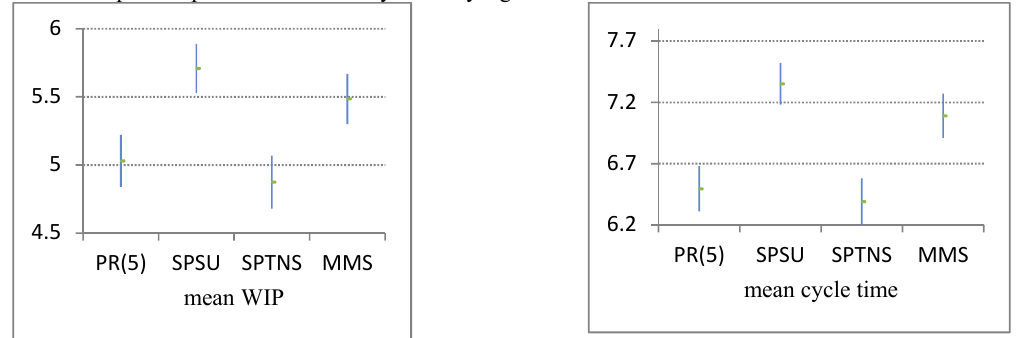
Fig. 12. Results from multiple comparison follow-up tests for mean WIP and mean cycle time (three machine